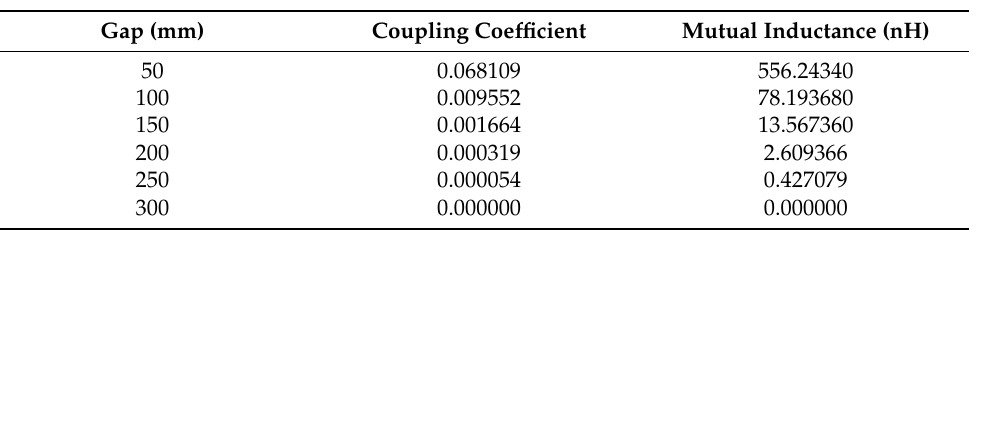
Table 2. Simulation results of rectangular coreless coil